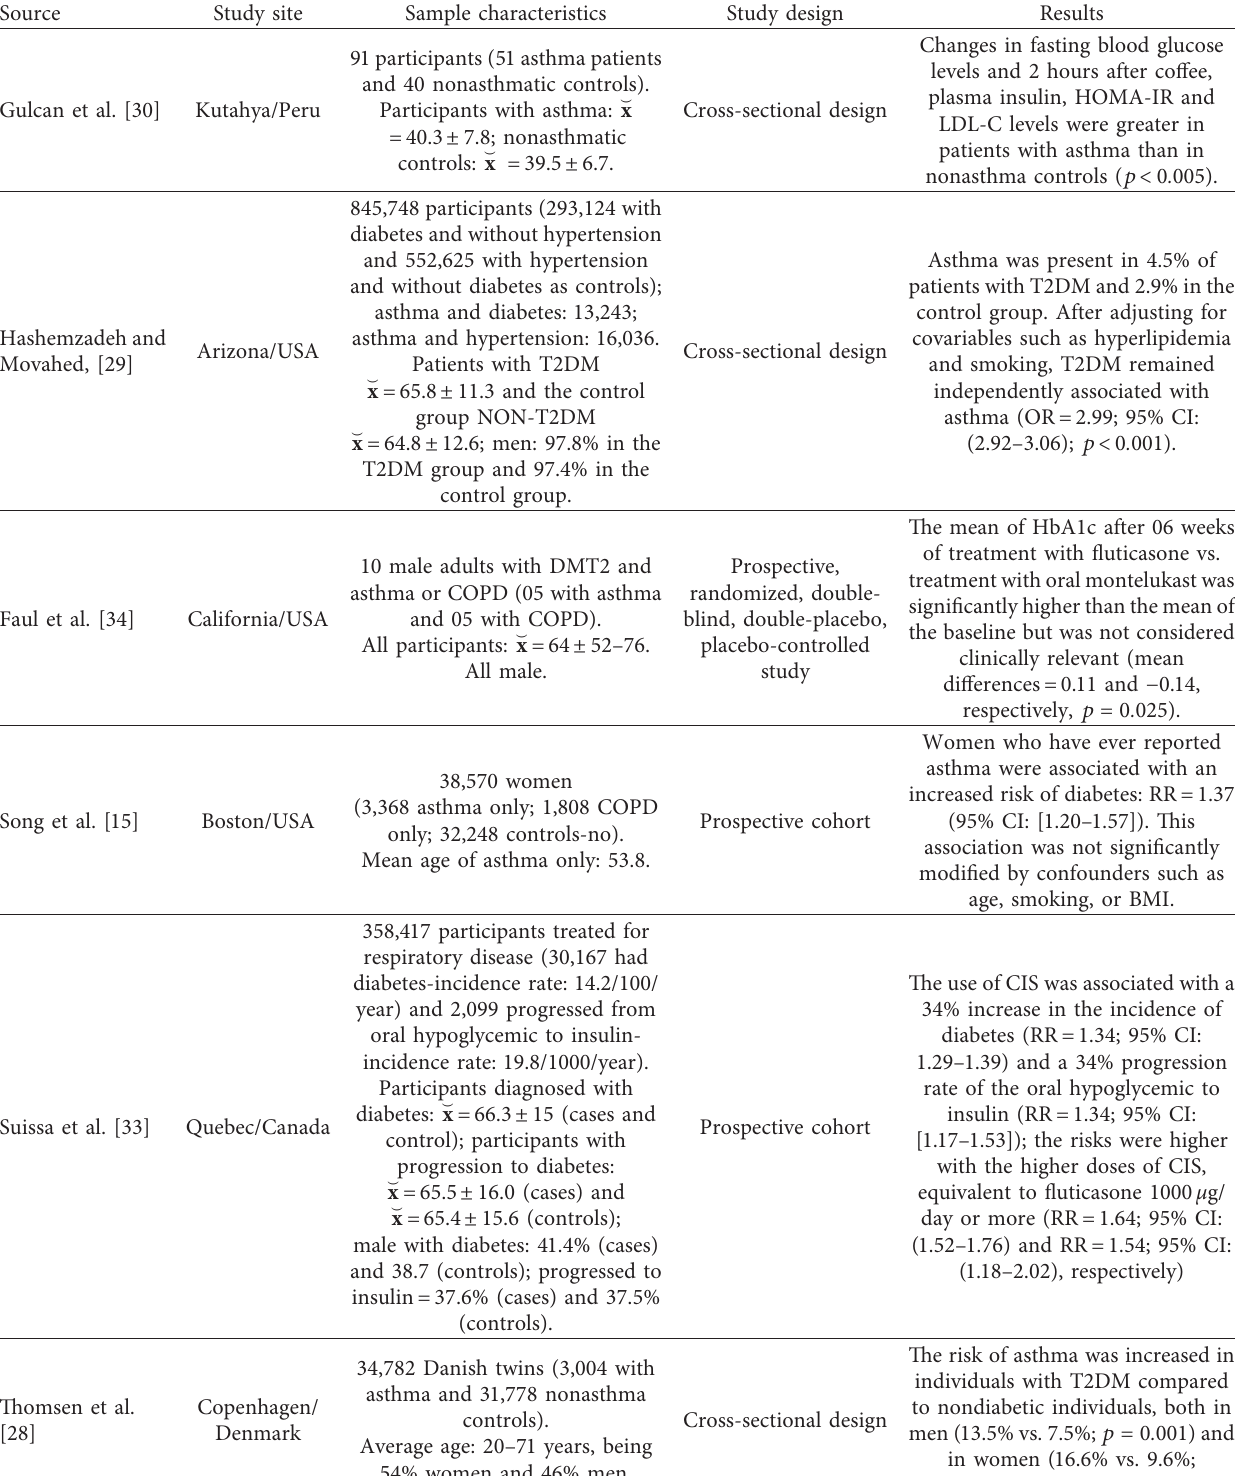
Table 1: Description of the articles,